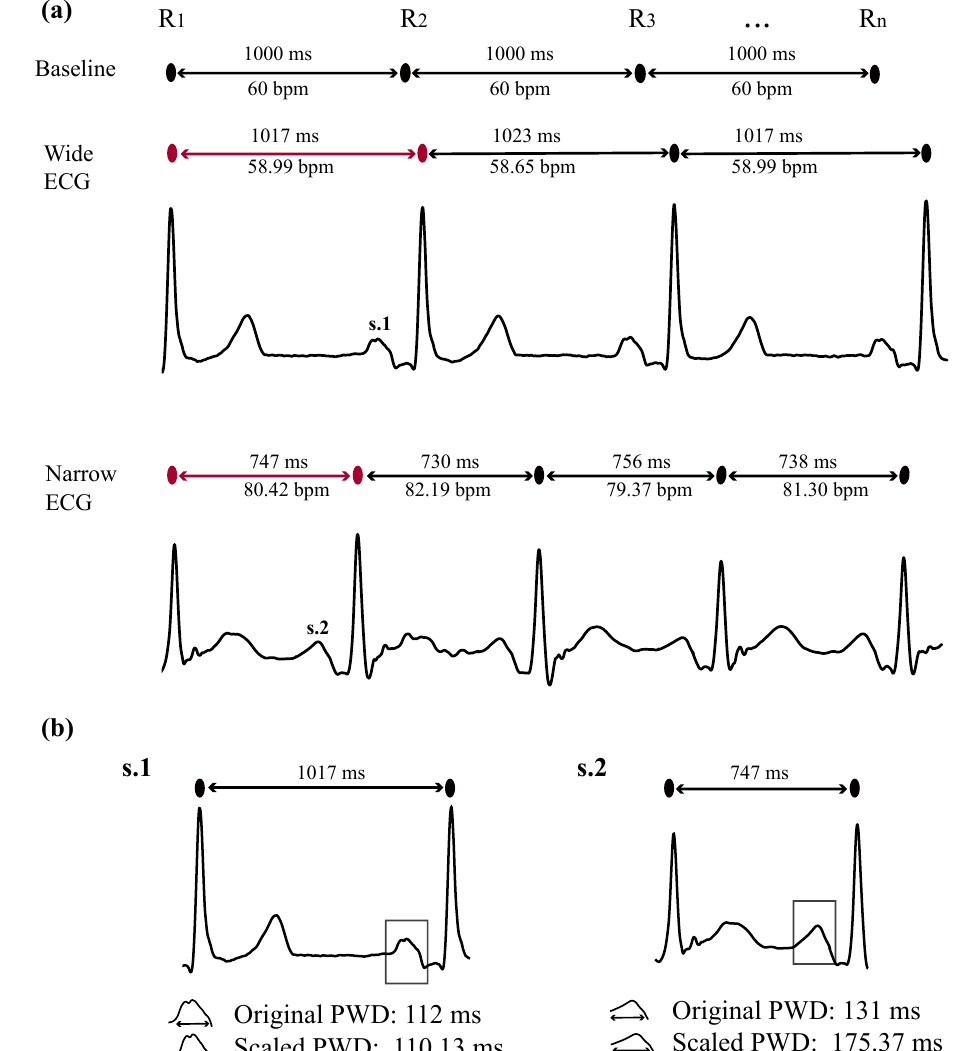
Figure 2. Example of P-wave scaling for interbeat intervals longer or shorter than 1000 ms. ( a ) Baseline interbeat interval at 1000 ms and interbeat intervals of a wide and a narrow ECG. Red intervals show the beats chosen to be analyzed as an example in ( b ). ( b ) PWD scaling for P-waves of a wide (s.1) and a narrow (s.2) signal. Wide signal: P-wave is shrunk after scaling. Narrow signal: P-wave is lengthened after scaling. The remaining features are scaled